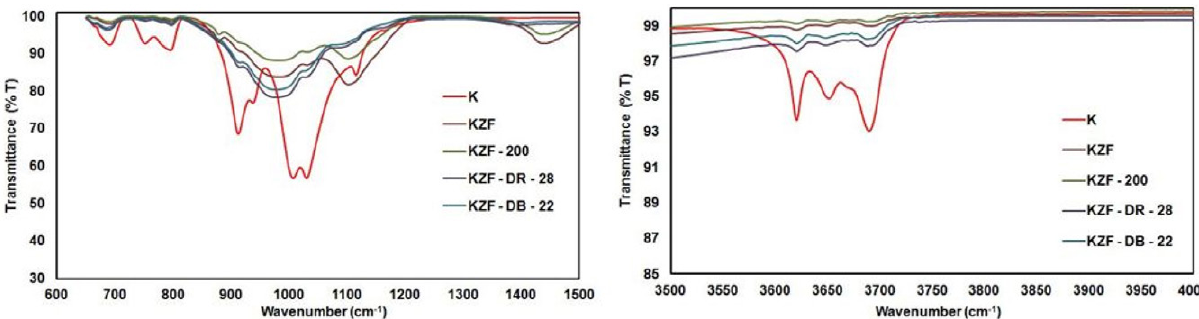
Fig. 1. The SEM (a), EDS spectra (b), EDS Mapping analyses (c) for KZF composite The functional groups of the kaolin, KZF, KZF-200 and DR-28 or DB-22 adsorbed KZF were determined using FTIR analysis. The related FTIR spectra are shown in Fig.